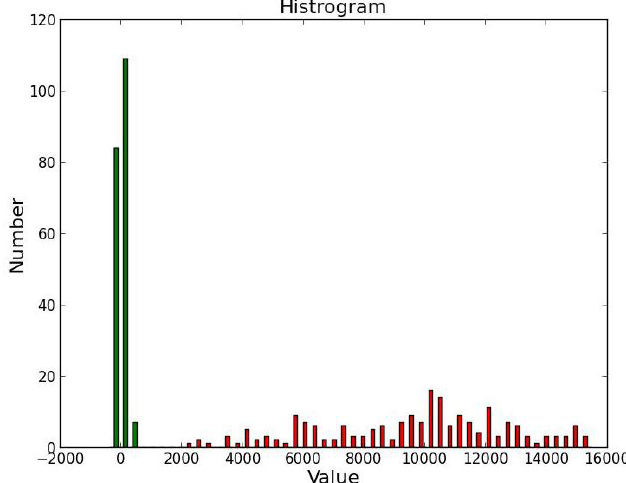
Figure 12. Histogram space between samples of marker bar area and other areas.